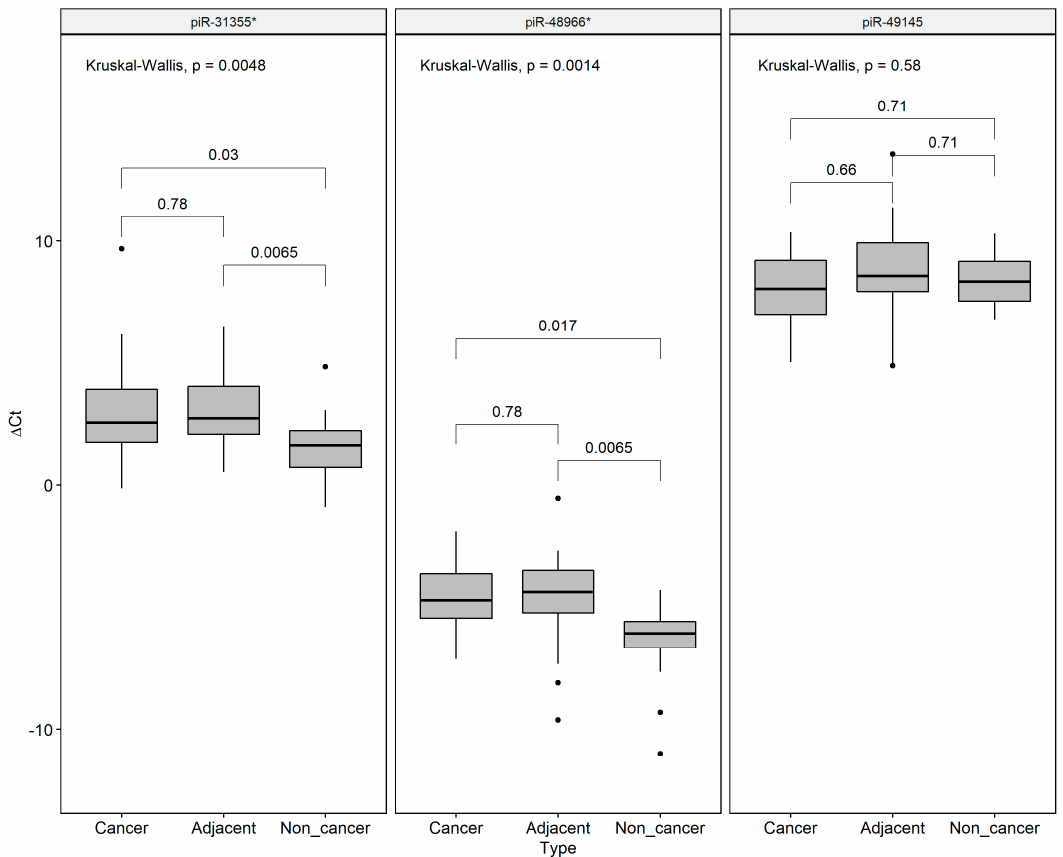
Figure 5. Expression values ( ∆ Ct ) of the field effect-related piRNAs (piR-48966* piR-49145 and piR-31355*) in gastric cancer, matched tumor-adjacent gastric tissue, and non-cancer samples, respectively. U6 Small Nuclear RNA (RNU6) was used as an endogenous control. * p -values were adjusted to multiple comparisons by Bonferroni’s correction. Individual black points (•) are outliers.